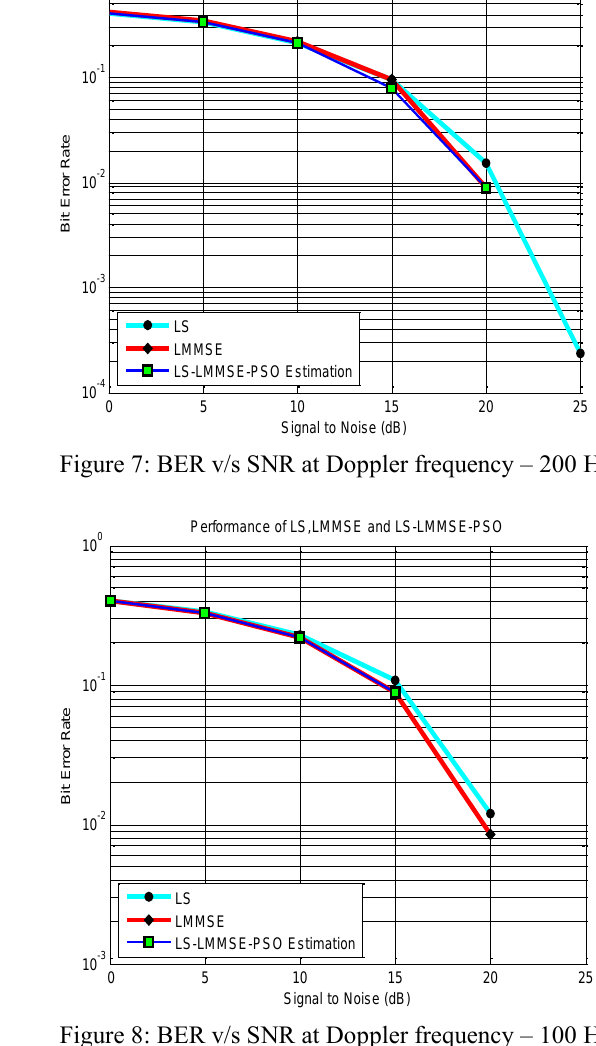
Figure 8: BER v/s SNR at Doppler frequency – 100